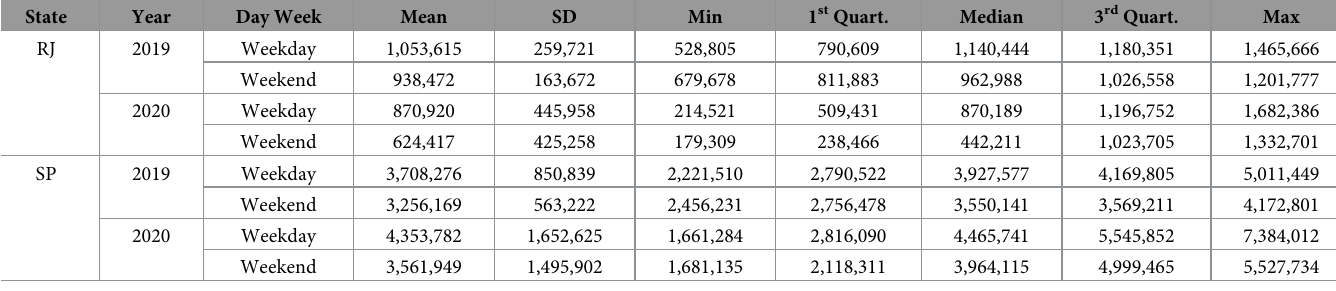
Table 1. Descriptive statistics of the daily number of recordings in March 2019 and 2020 for each state on the weekends and weekdays.